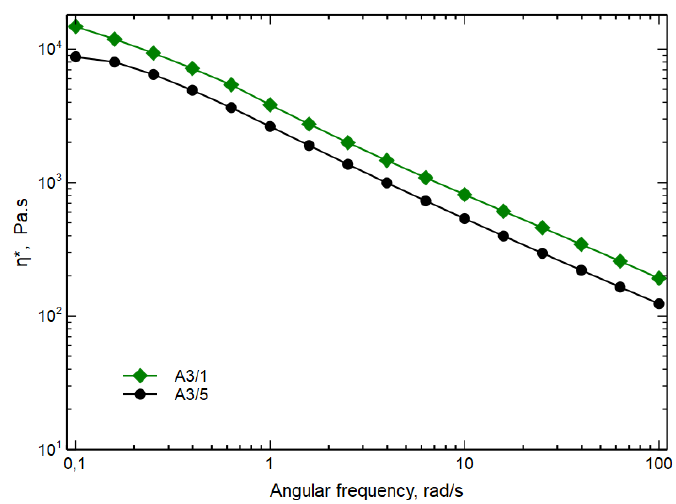
Figure 8. Complex viscosity as function of angular frequency of A3/1 and A3/5 blends.